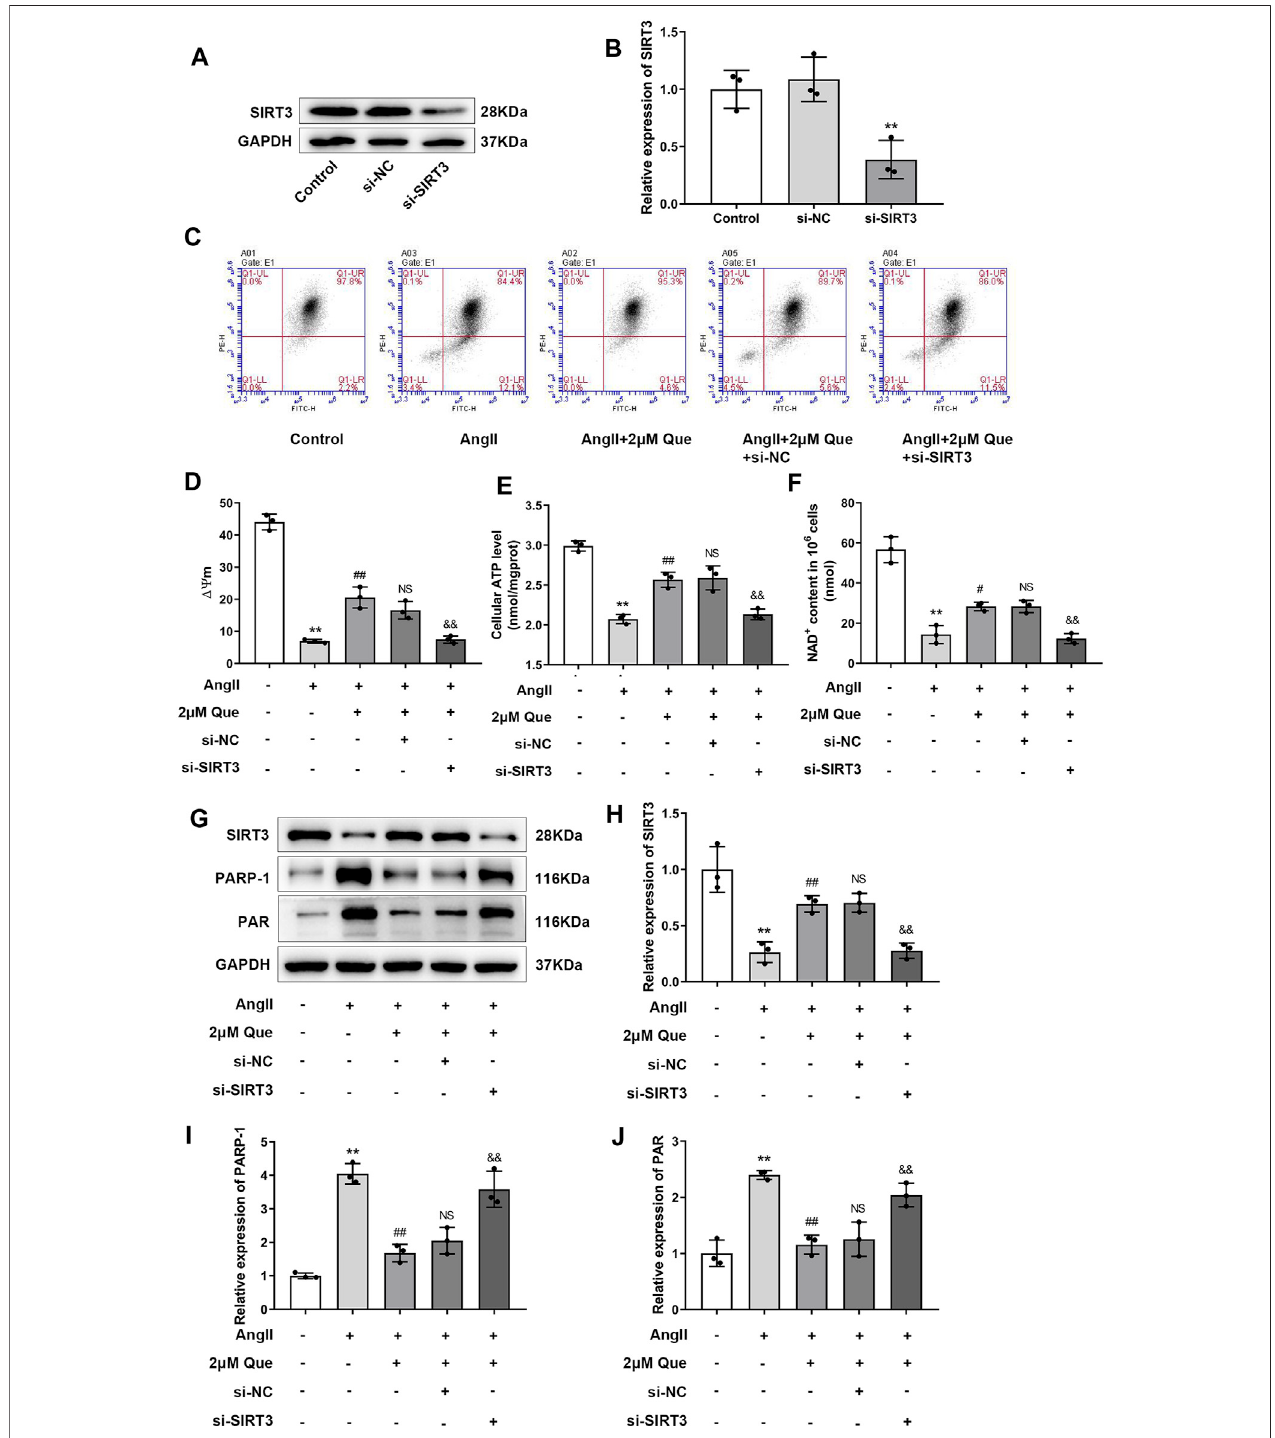
FIGURE 5 | Quercetin protects mitochondrial function via SIRT3/PARP-1 pathway. (A,B) Representative blots of siRNA-SIRT3-mediated transfection ef fi ciency and densitometric quanti fi cation after normalization to GAPDH levels (n (cid:1) 3). (C) ΔΨ m measurement with the JC-1 probe. (D) Quanti fi cation of ΔΨ m by the aggregate/ monomer ratios (n (cid:1) 3). (E) Quanti fi cation of cellular ATP levels with the intracellular ATP Assay Kit (n (cid:1) 3). (F) Introcellular levels of nicotinamide adenine dinucleotide (NAD + )determinedbyNAD + /NADHassaykit(n (cid:1) 3). (G – J) RepresentativeblotsofSIRT3,PARP-1andPAR,anddensitometricquanti fi cationafternormalizationto GAPDHlevels(n (cid:1) 3).Dataaremean ± SD.* p < 0.05,** p < 0.01 vs controlgroup; # p < 0.05, ## p < 0.01 vs AngIIgroup; NS P > 0.05 vs AngII+2 μ mQuegroup; & p < 0.05, && p < 0.01 vs Ang II + 2 μ m Que group.